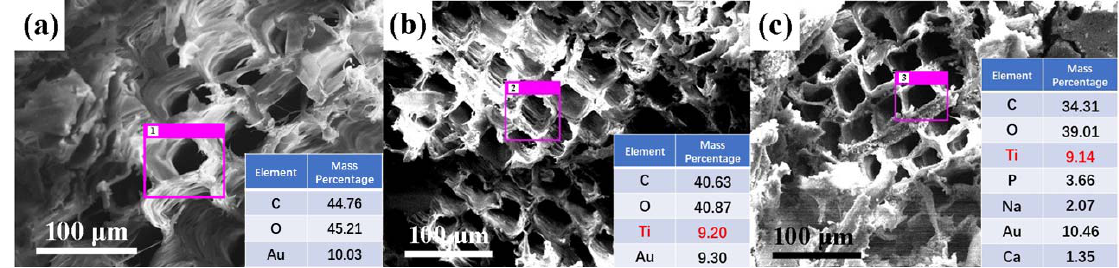
Figure 3. Energy ‐ dispersive spectroscopy (EDS) of ( a ) original wood, ( b ) UW, and ( c ) VW. Data pertain to the selected area within the pink boxes.